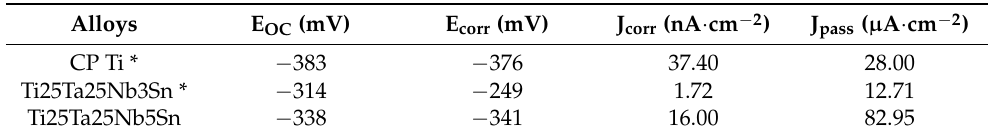
Table 2. Parameters obtained by corrosion tests for the Ti25Ta25Nb5Sn alloy compared to the CP Ti and Ti25Ta25Nb3Sn alloys. Corrosion tests were performed on fluoridated physiological